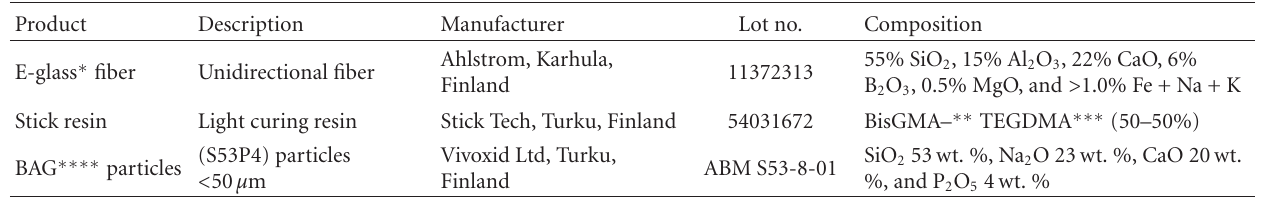
Table 1: Materials used in the investigation.